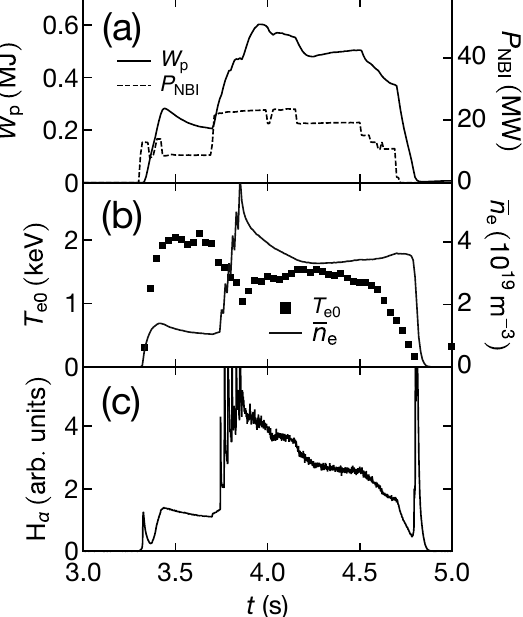
Figure 3. Temporal development of the discharge: ( a ) neutral beam injection power P NBI and stored energy W p , ( b ) line-averaged electron density n e and central electron temperature T e0 (obtained from a far-infrared laser interferometer and Thomson scattering data, respectively), and ( c ) H α intensity measured with a system based on an interference filter and a photomultiplier.